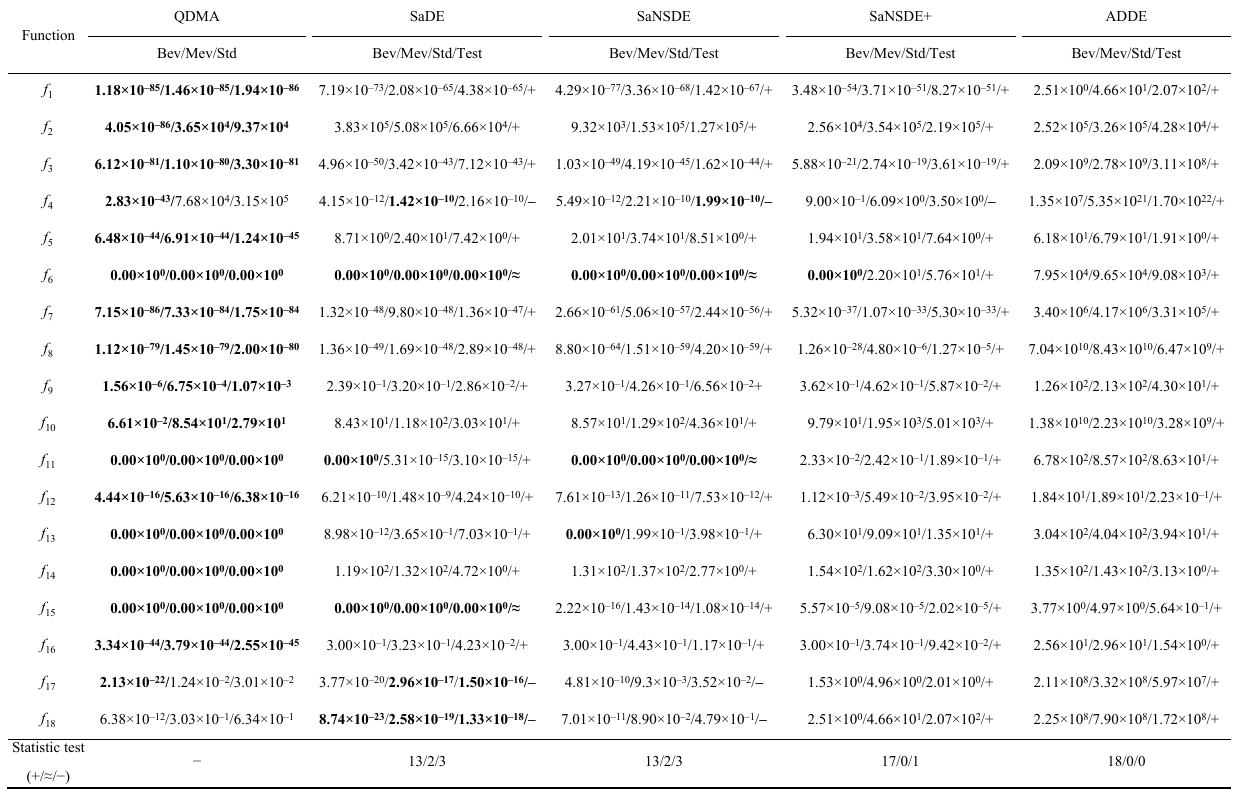
Table A5 Comparison of QDMA and different DE variants on 100 D problems.